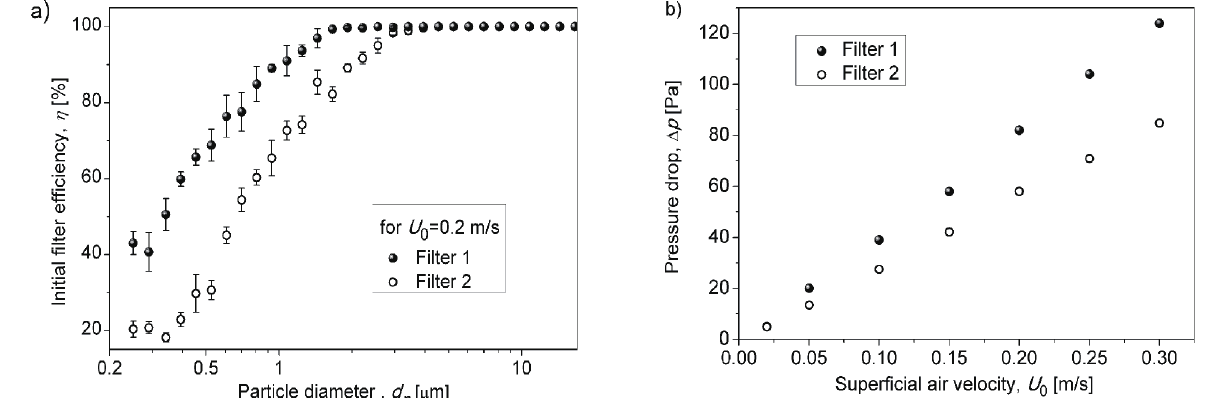
Fig. 4 Initial filter performance: a) filter efficiency vs. particle diameter and b) pressure drop vs. face velocity for Filter 1 and Filter 2. Table 2 Characteristic of the filters made of two